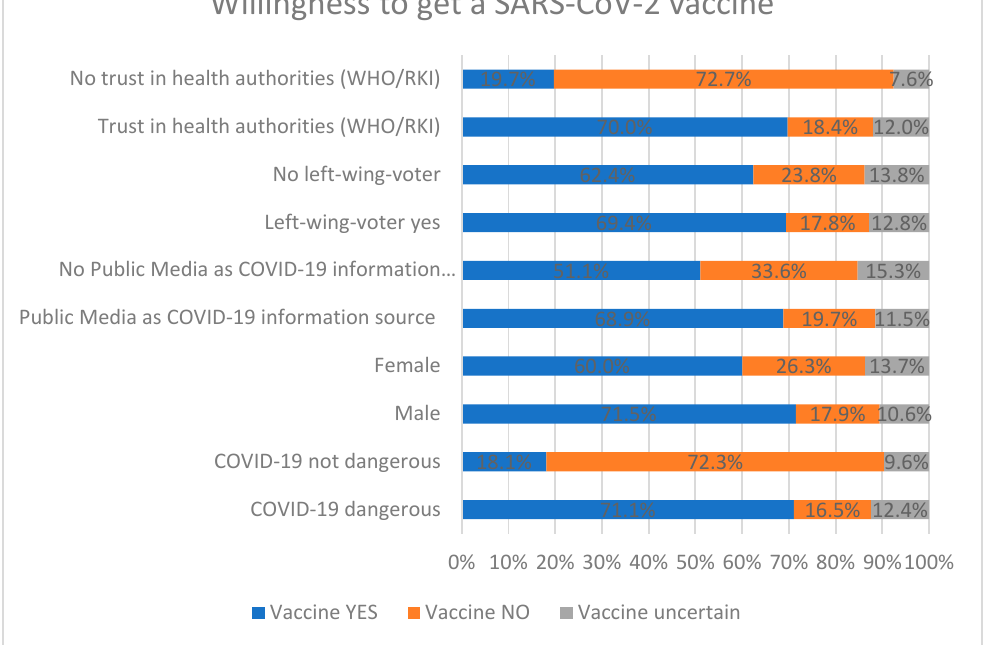
Figure 2. Determinants of willingness to get vaccinated against SARS-CoV-2.